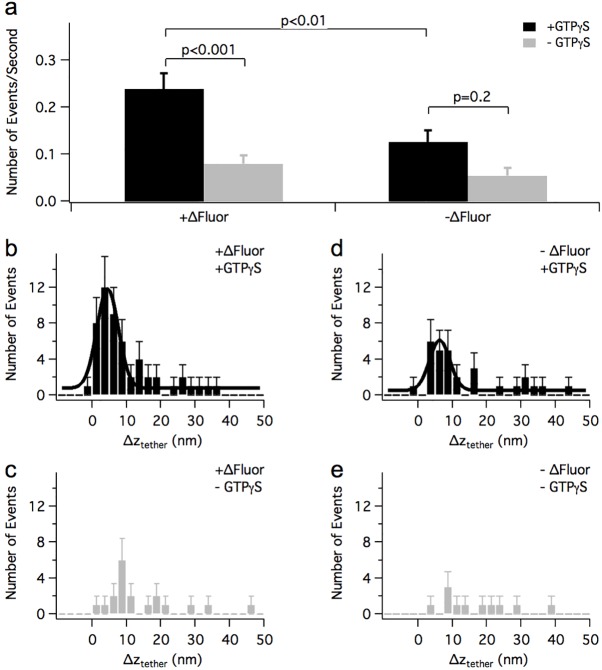
Properties of vesicle-plasma membrane tether extension events.(a) Dependence of the frequency of tether extension events <50 nm under force clamp on the presence of GTPγS and ΔFluor. P values were determined using a Poisson test. (b-e) histograms of Δztether for conditions as indicated. Histogram bins have width = 2.5 nm and are centered at −8.75 to 48.75 nm. Negative values were allowed to account for measurement noise. Error bars are the square root of the number of events in the bin. The smooth lines in (b) and (d) are Gaussian fits.